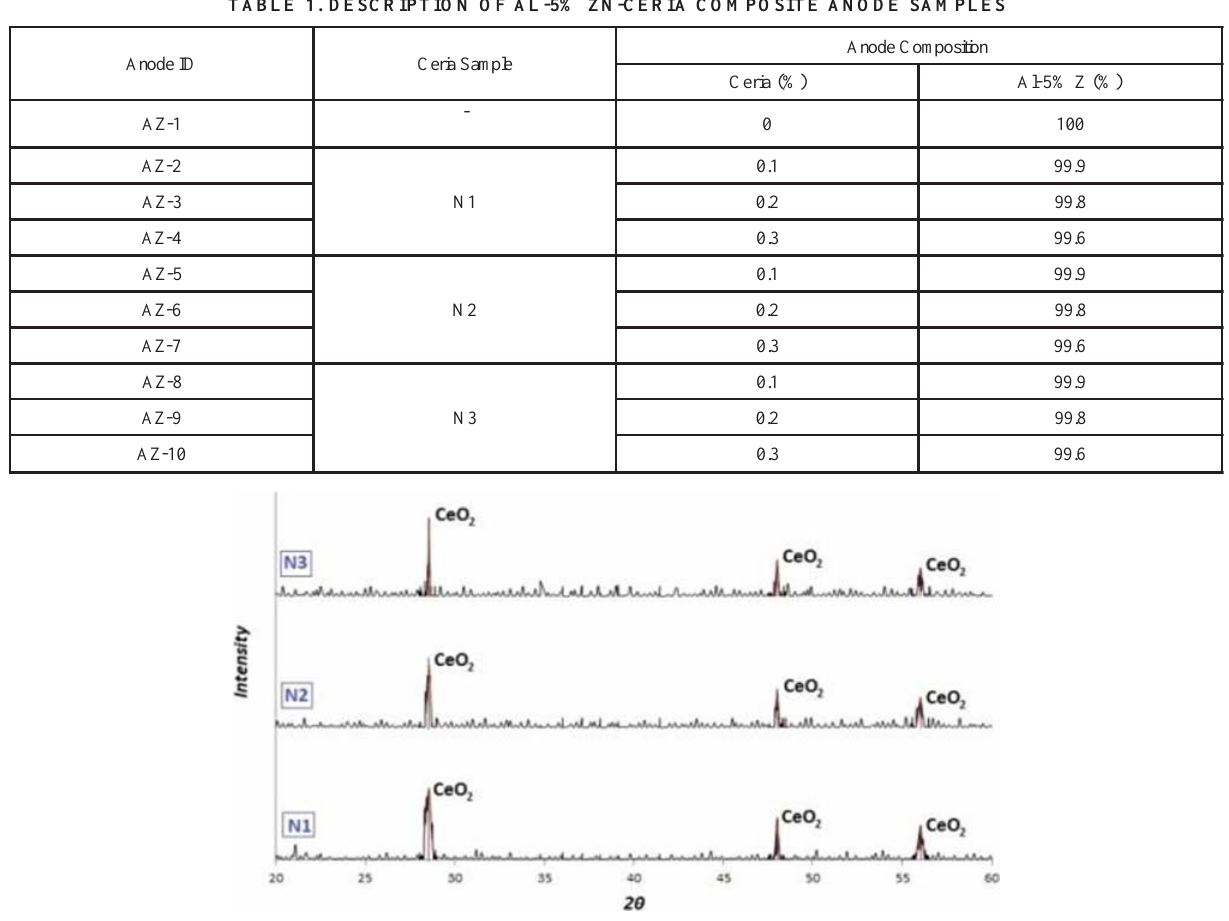
FIG. 1. XRD PATTERNS OF NANO CERIUM OXIDE NC1, NC2 AND